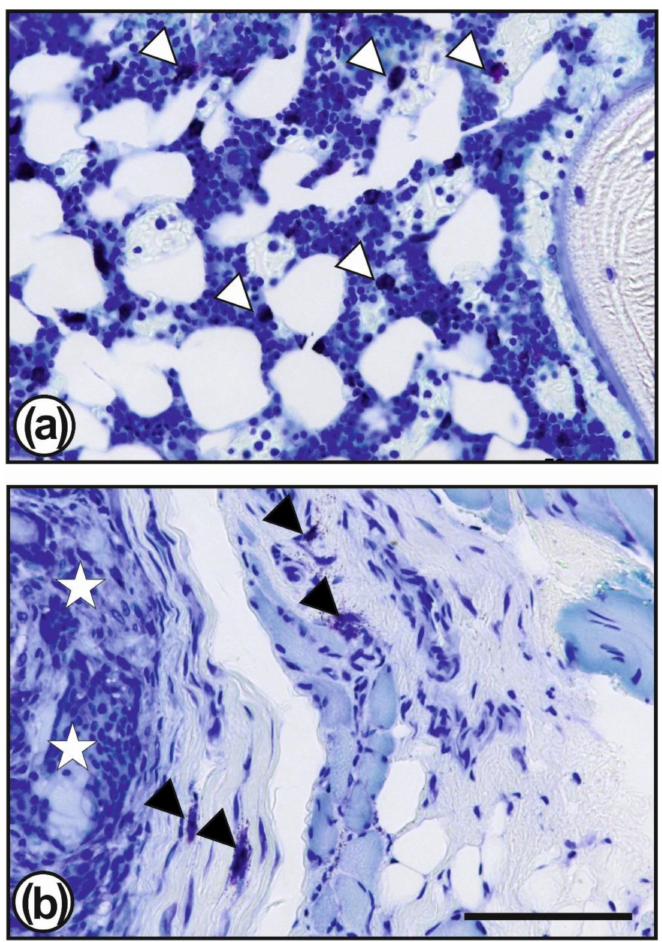
Figure 5. Toluidine blue staining showed mast cells (some of them are marked by white or black triangles) which are present numerously in the vicinity of the surgical site, especially in the bone marrow ( a ) but also in the granulation tissue surrounding the TGF– β 3–CS–g–PCL fibre sca ff olds ( b ; sca ff old is marked by white stars). Bar = 50 µ